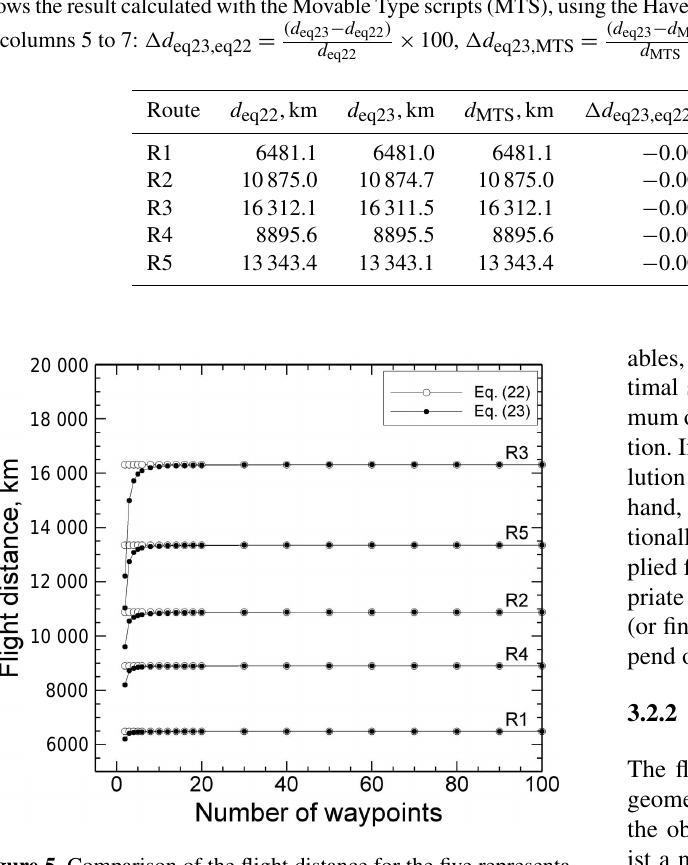
Figure 5. Comparison of the flight distance for the five representa- tive routes. ◦ : great circle distance calculated by Eq. (22); • : great circle distance calculated by Eq.